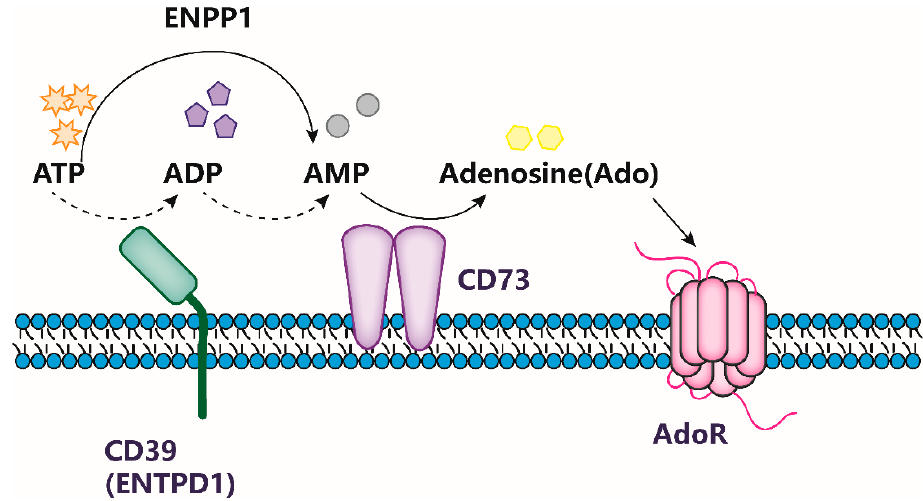
Figure 1. CD73 accelerates the accumulation of ADO. Purine metabolism by the ecto-nucleotidase CD73 is widespread. CD73, a plasma membrane GPI-anchored glycoprotein, collaborates with CD39 to convert ATP to AMP. Ecto-nucleotide pyrophosphatase/phosphodiesterase-1 (ENPP1) can directly convert ATP to AMP. CD73 is the main enzyme that dephosphorylates AMP to produce extracellular adenosine (Ado); however, tissue non-specific alkaline phosphatase (TNAP) or prostatic acid phosphatase (PAP) can also carry out this activity.